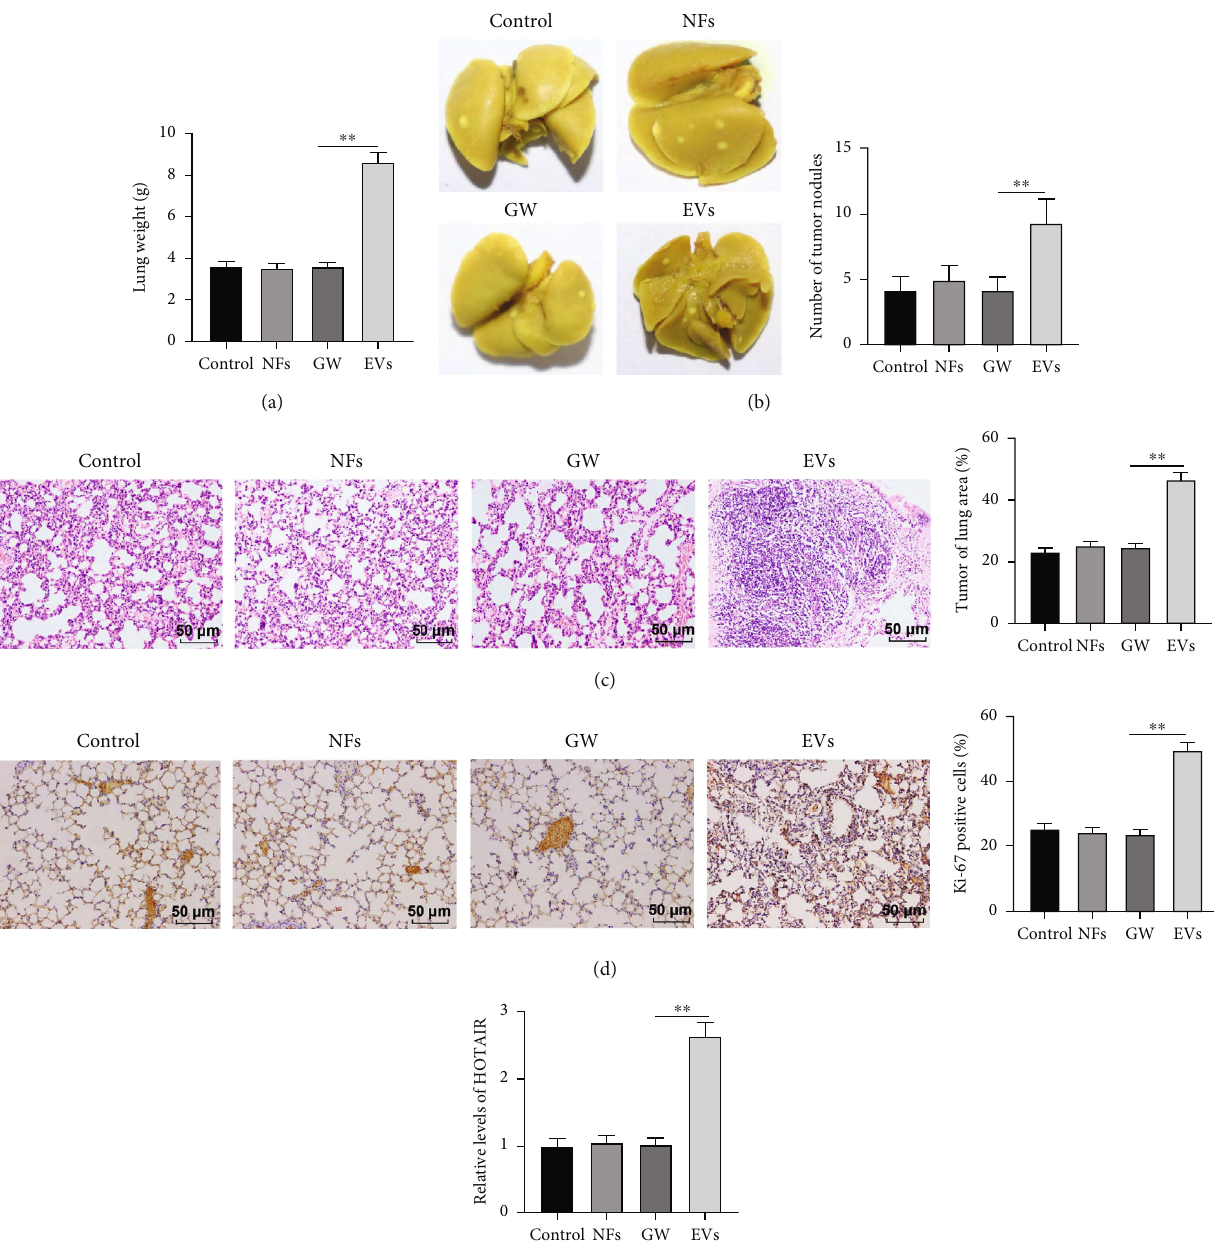
Figure 6: T-EVs promoted metastasis of LC in vivo by activating CAFs. A549 cells ( 2 × 10 6 ) of each group were injected into nude mice via the tail vein. After 8 weeks, (a) The lung tissue was weighted, N = 12 ; (b) the number of tumor nodules was counted, N = 12 ; (c) HE staining was used to detect tumor foci in lung tissue, N = 6 ; (d) Ki-67-positive cells were detected by immunohistochemistry, N = 6 ; and (e) RT-qPCR was used to detect HOTAIR levels in lung tissues, N = 12 . One-way ANOVA was used for data comparison among multiple groups, and Tukey ’ s test was used for the post hoc test. ∗∗ P < 0 : 01